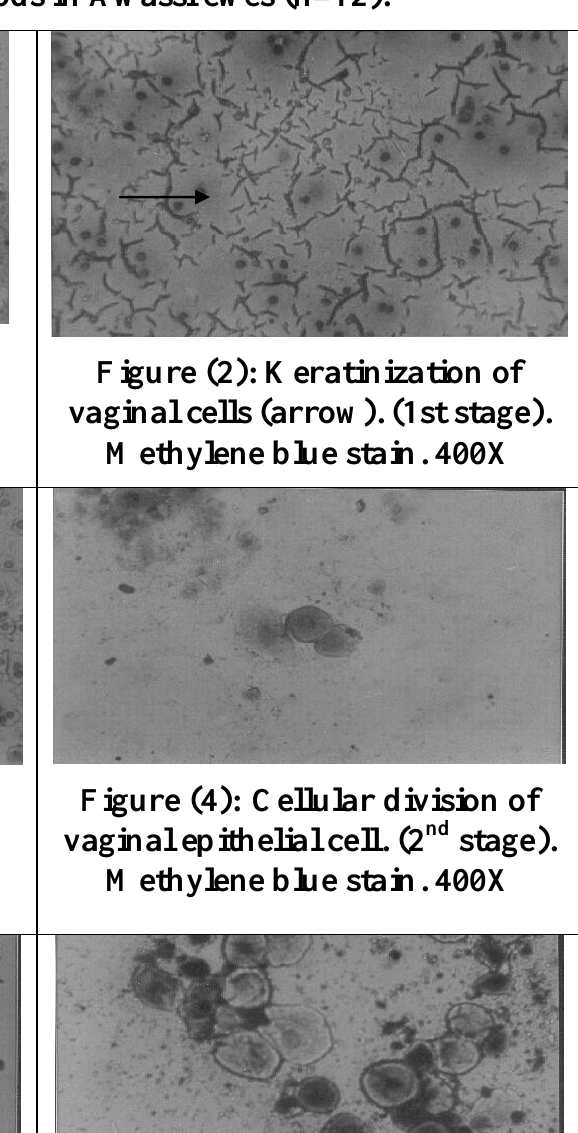
Figure (3): Cellular division of vaginal epithelium . (2 nd stage). Methylene blue stain. 400X